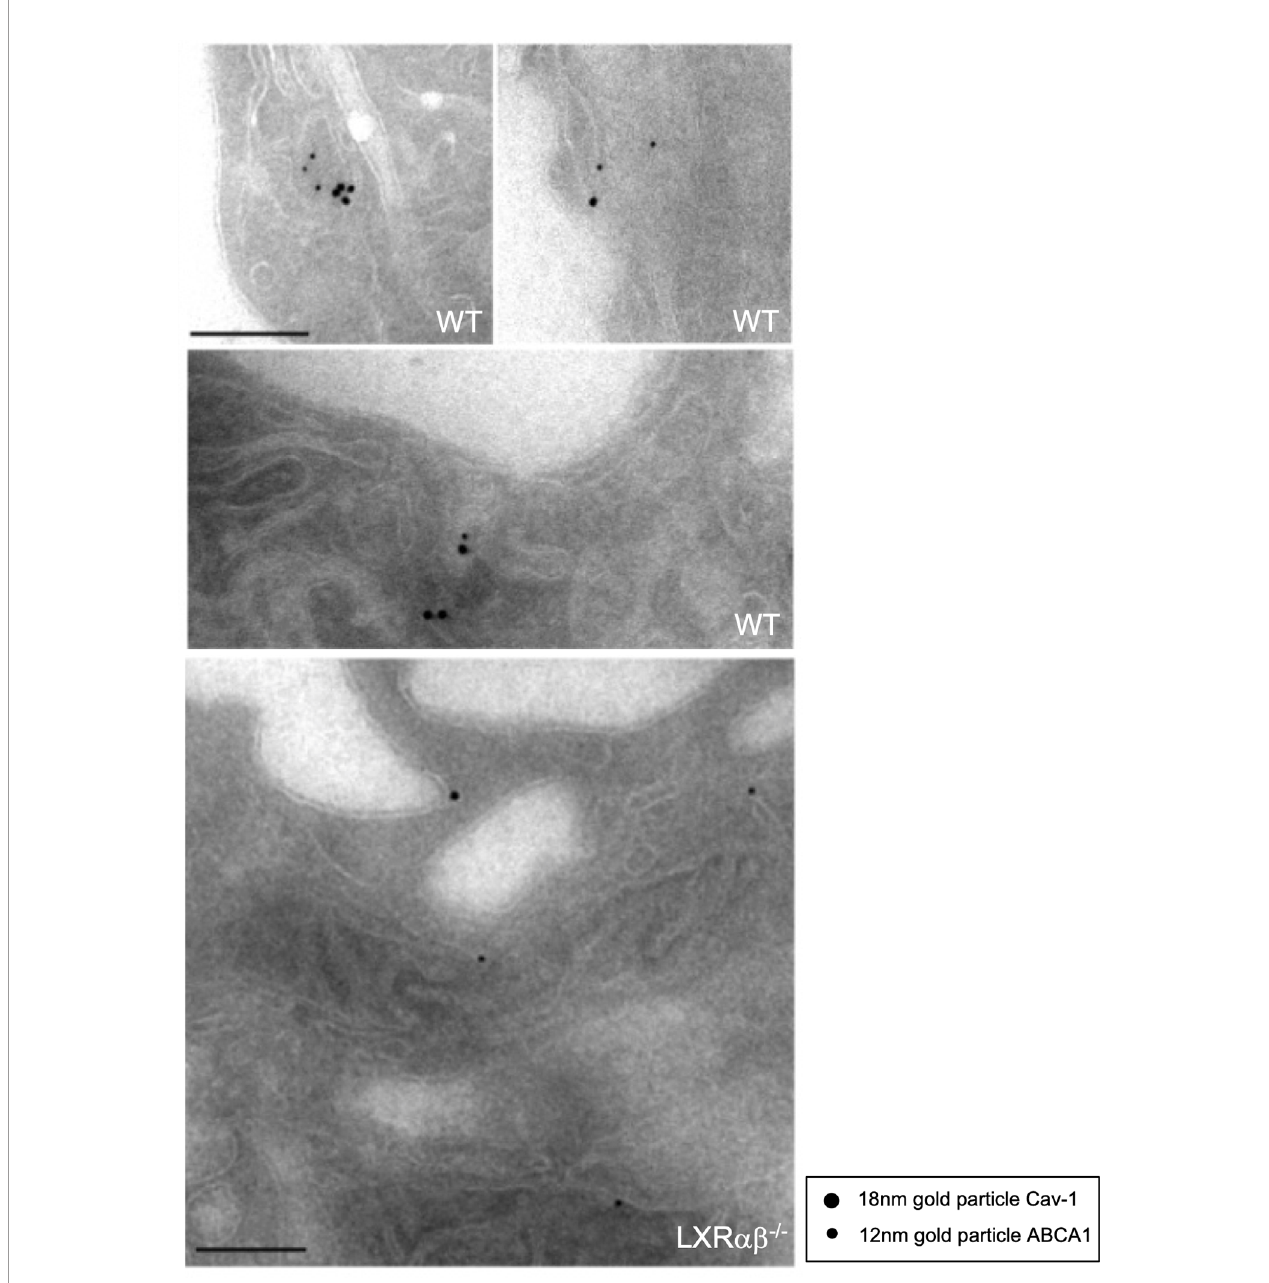
FIGURE 4 | Colocalization of Cav-1 and ABCA1 within sub-cellular domains of peritoneal macrophages. Representative immuno-electron microscopy images showing Cav-1 and ABCA1 expression in peritoneal macrophages from WT and LXR ab -/- mice. Scalebar: